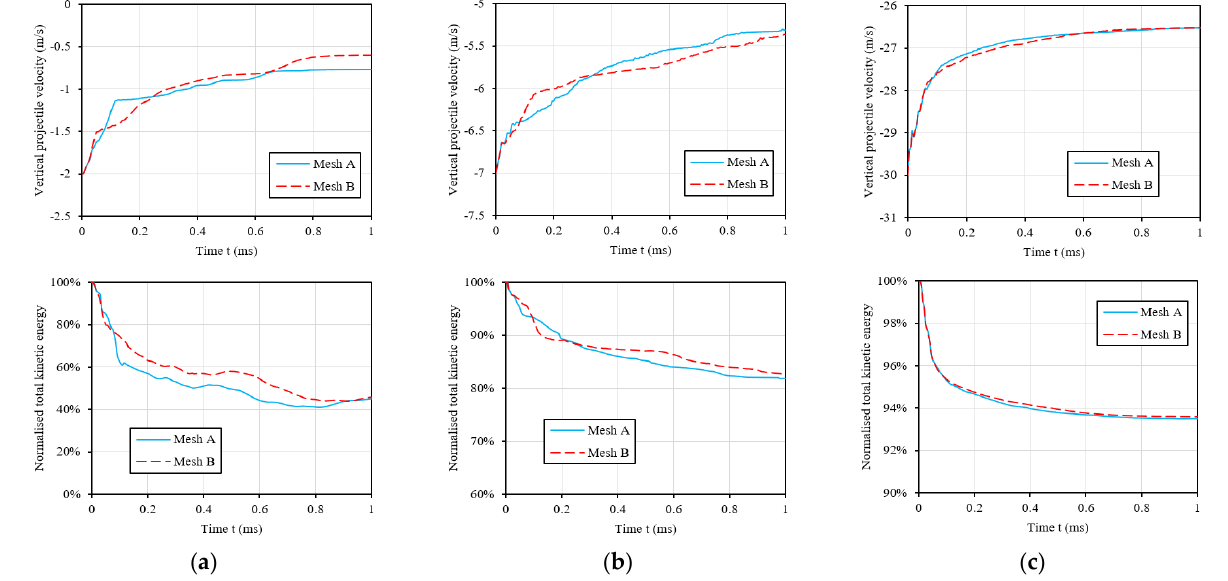
Figure 13. Time histories of impact responses: ( a ) v = 2 m/s; ( b ) v = 7 m/s; ( c ) v = 30 m/s.